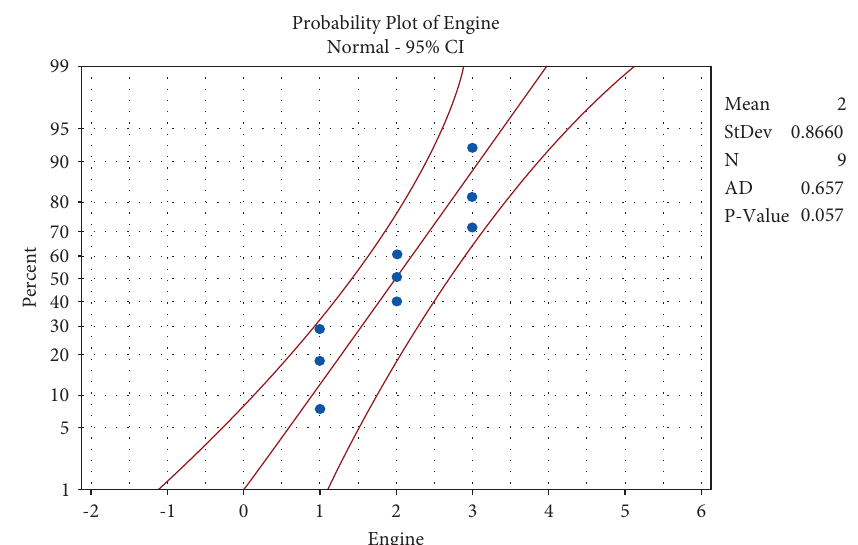
Figure 16: Probability plot of